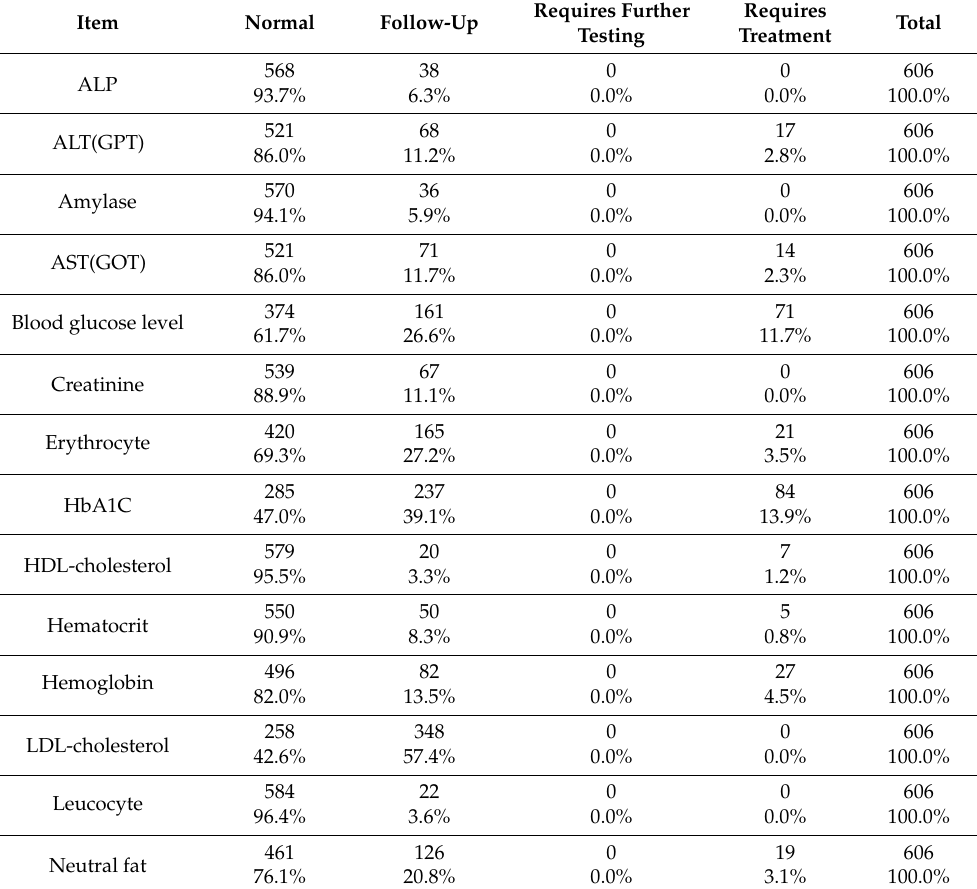
Figure 1. Results of degree of dementia in daily living (2018). Table 2. Results of biochemical examination